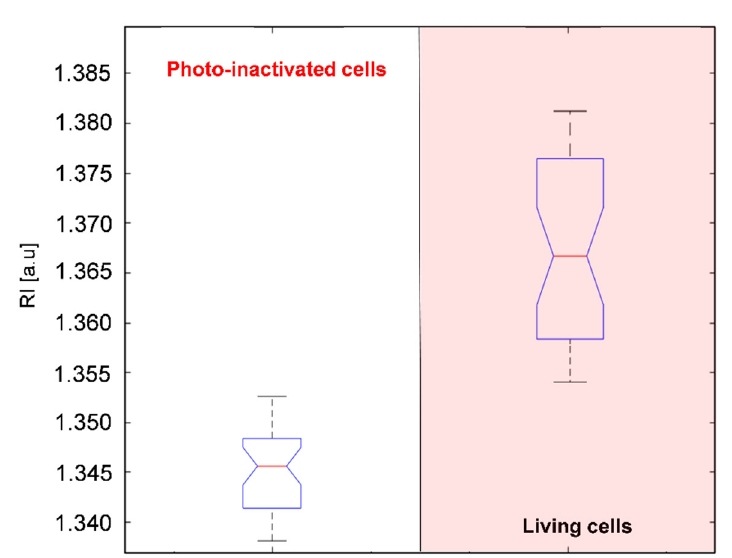
Figure 8. Representative boxplot showing the changes of RI values of photo-inactivated and living cells of E. coli on the surface of AVC-Ce6 material within 3 h of examination.